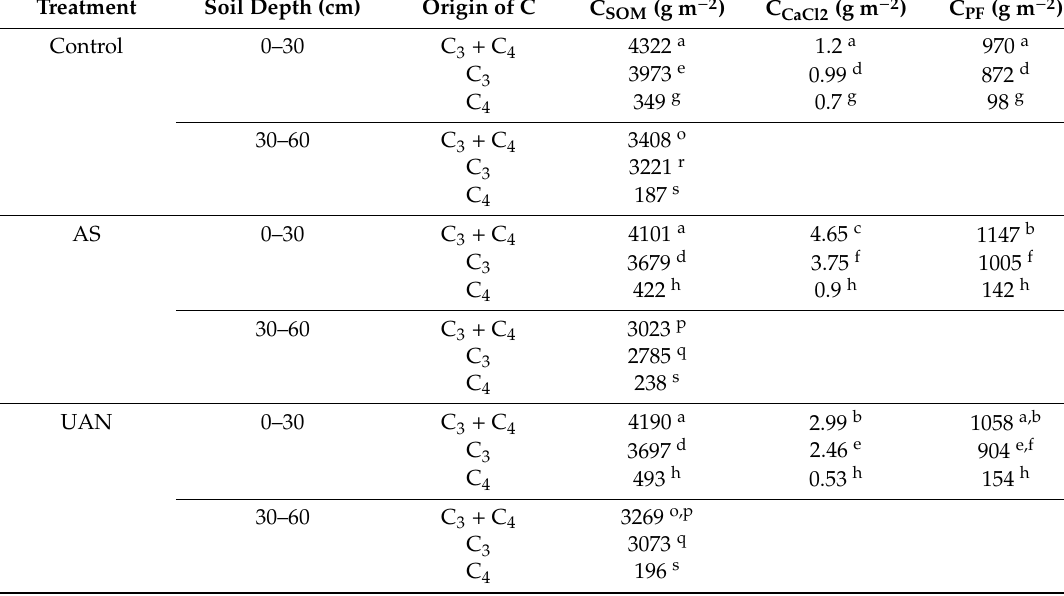
Table 3. Carbon content in topsoil and subsoil; AS—ammonium sulfate, UAN—urea ammonium nitrate, C—carbon, C SOM —soil organic matter carbon, C CaCl2 —carbon determined with 0.01 mol L −